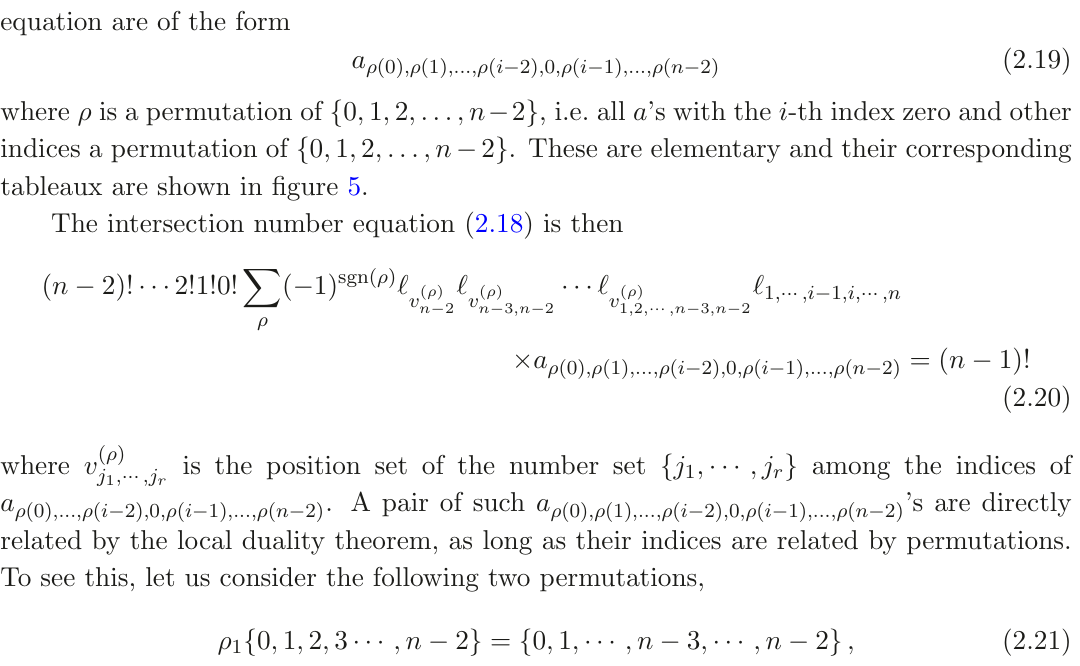
{ 0 , 0 , 1 , 2 , ··· ,n − 3 ,n − 2 }